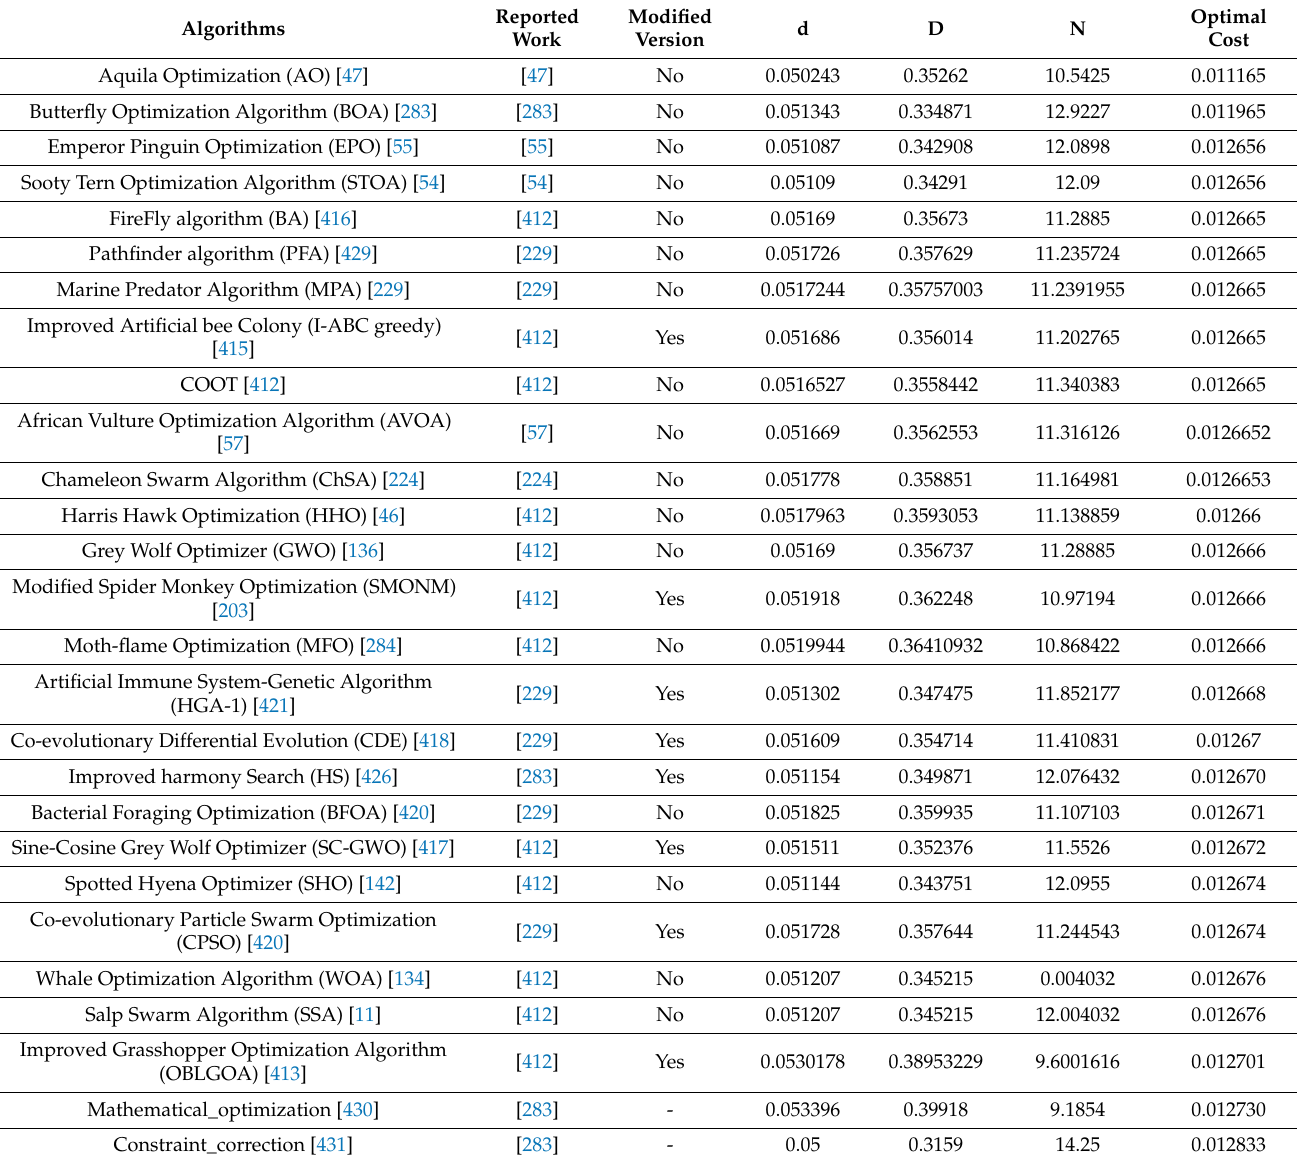
Table 10. Solutions for the tension/compression